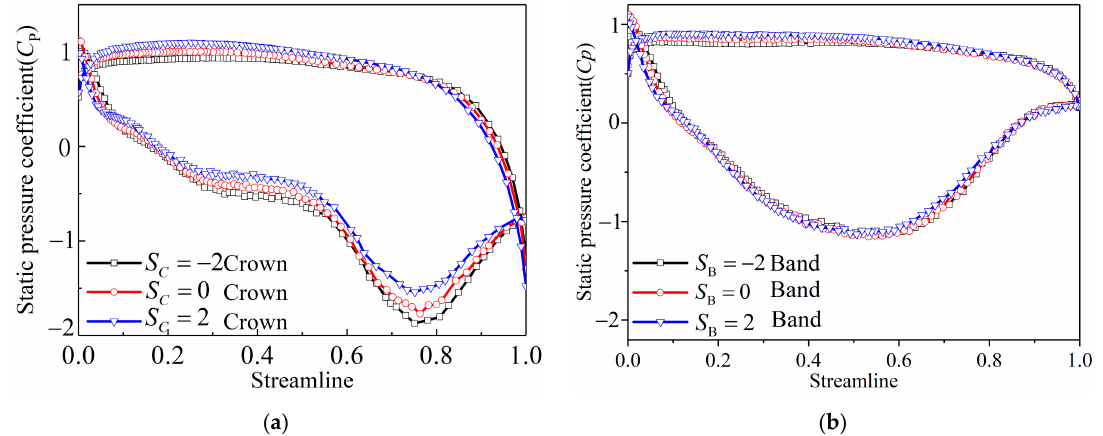
Figure 11. Static pressure coefficient distributions at both the crown and band for different S C (the